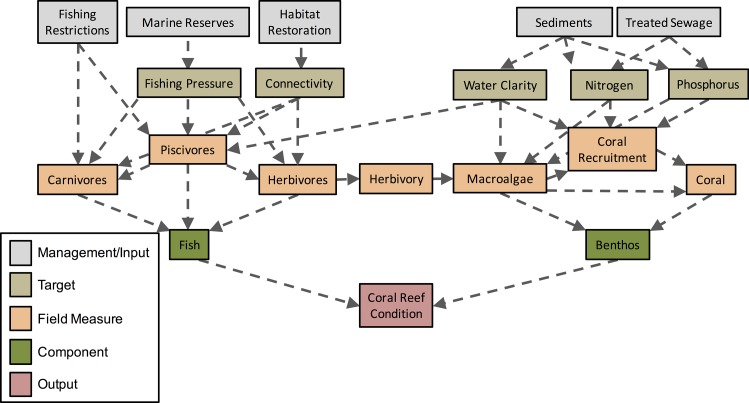
Conceptual diagram outlining the relationship between management actions and various components linked to coral reefs in Moreton Bay.